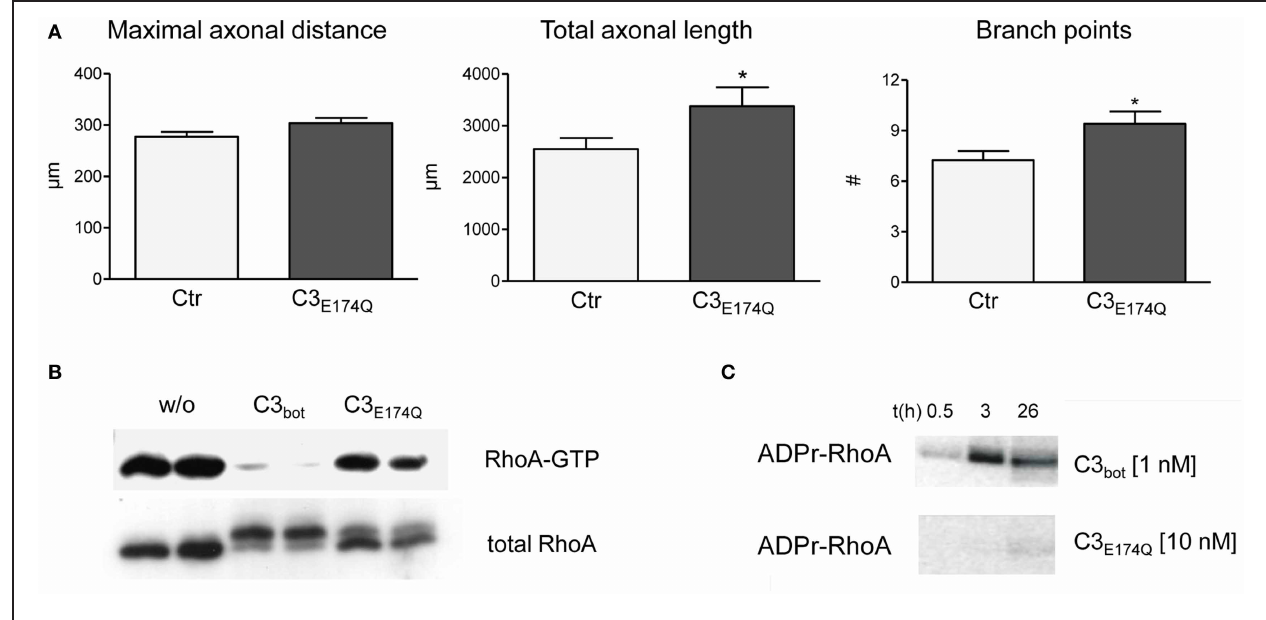
FIGURE 5 | Compared to vehicle-treated control neurons mutant C3 E 174 Q (1 μ g/ml, non-permeable) stimulates axonal growth, but does not improve axonal elongation ( A ; total number of neurons per group > 240, three independent experiments, mean ± SEM; ∗ p < 0 . 05). Pull down assays